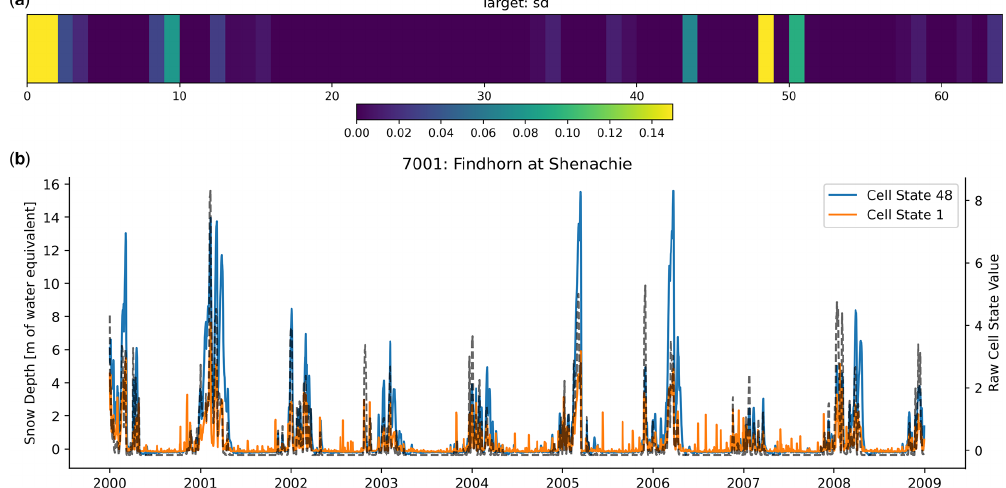
Figure 7. (a) We visualize the most informative weights where lighter colours mean larger weights assigned to that cell-state dimension by the linear probe. (b) The largest two dimensions, in terms of their assigned weight, from the above plot are then overplotted on the snow depth target time series (grey-dashed line), showing that they really do contain information about the winter snow signal, particularly Cell State 48, which varies very little in the summer